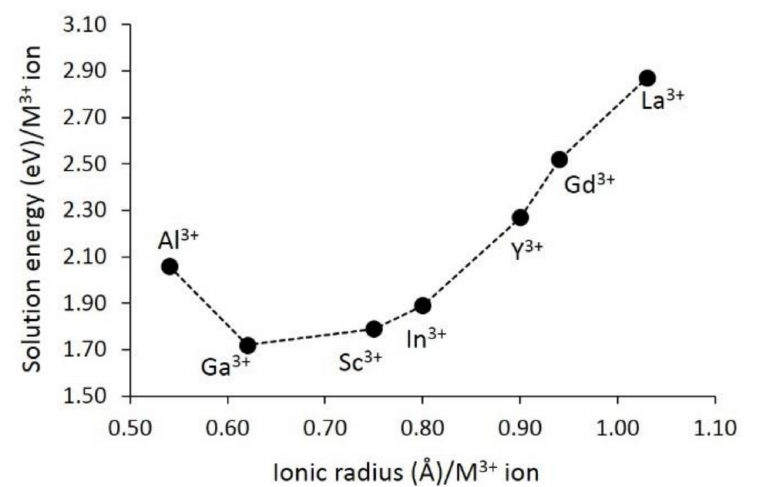
Figure 5. Solution energies calculated for M 2 O 3 (M = Al, Ga, Sc, In, Y, Gd, and La) on the Zr site with respect to the M 3+ ionic radius.